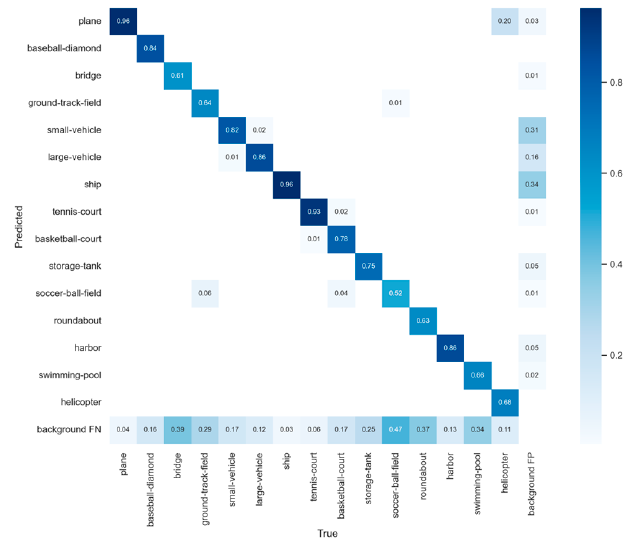
Figure 8. Confusion matrix of DCE_YOLOX.